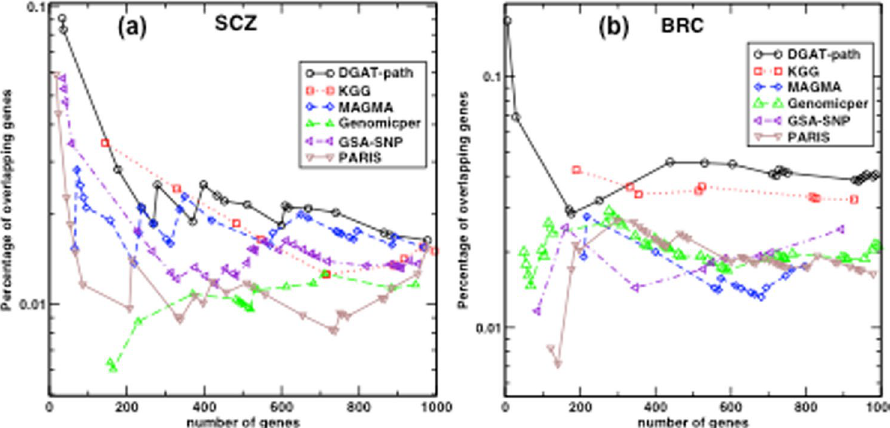
Figure 4. The percentages of genes overlapping with the associated genes from recent GWAS catalogs as a function of the total number of genes in different numbers of top pathways detected by methods on the datasets of ( a ) SCZ ( b ) breast